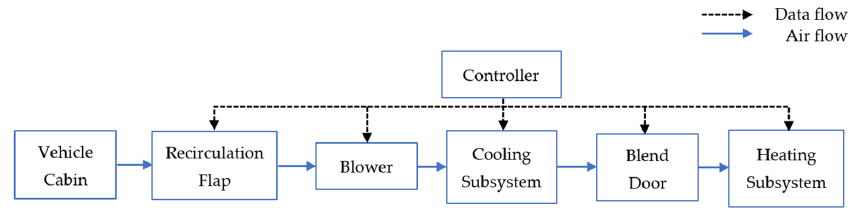
Figure 1. An overview of the cooling and heating subsystems in a conventional vehicle HVAC system.